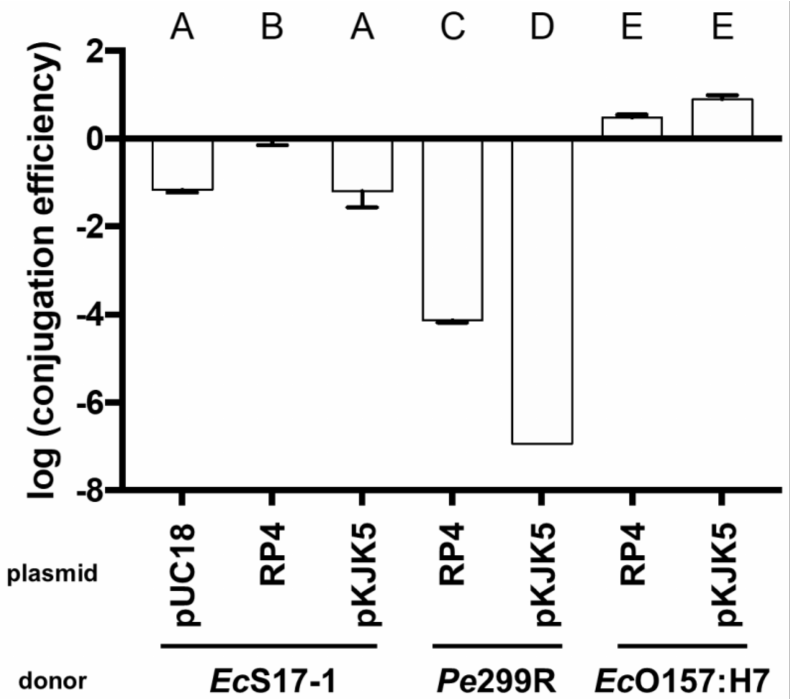
Figure 2. Transconjugant frequencies in the recipient population after mating of the recipient Ec O157:H7red with Ec S17-1, Pe 299R, and Ec O157:H7 donors carrying plasmids pUC18, pKJK5, or RP4 on nitrocellulose filters. Error bars represent the standard deviation of the mean. Significant differences between treatments are marked with different letters ( p -value < 0.01, one-way ANOVA, Tukey’s multiple comparison